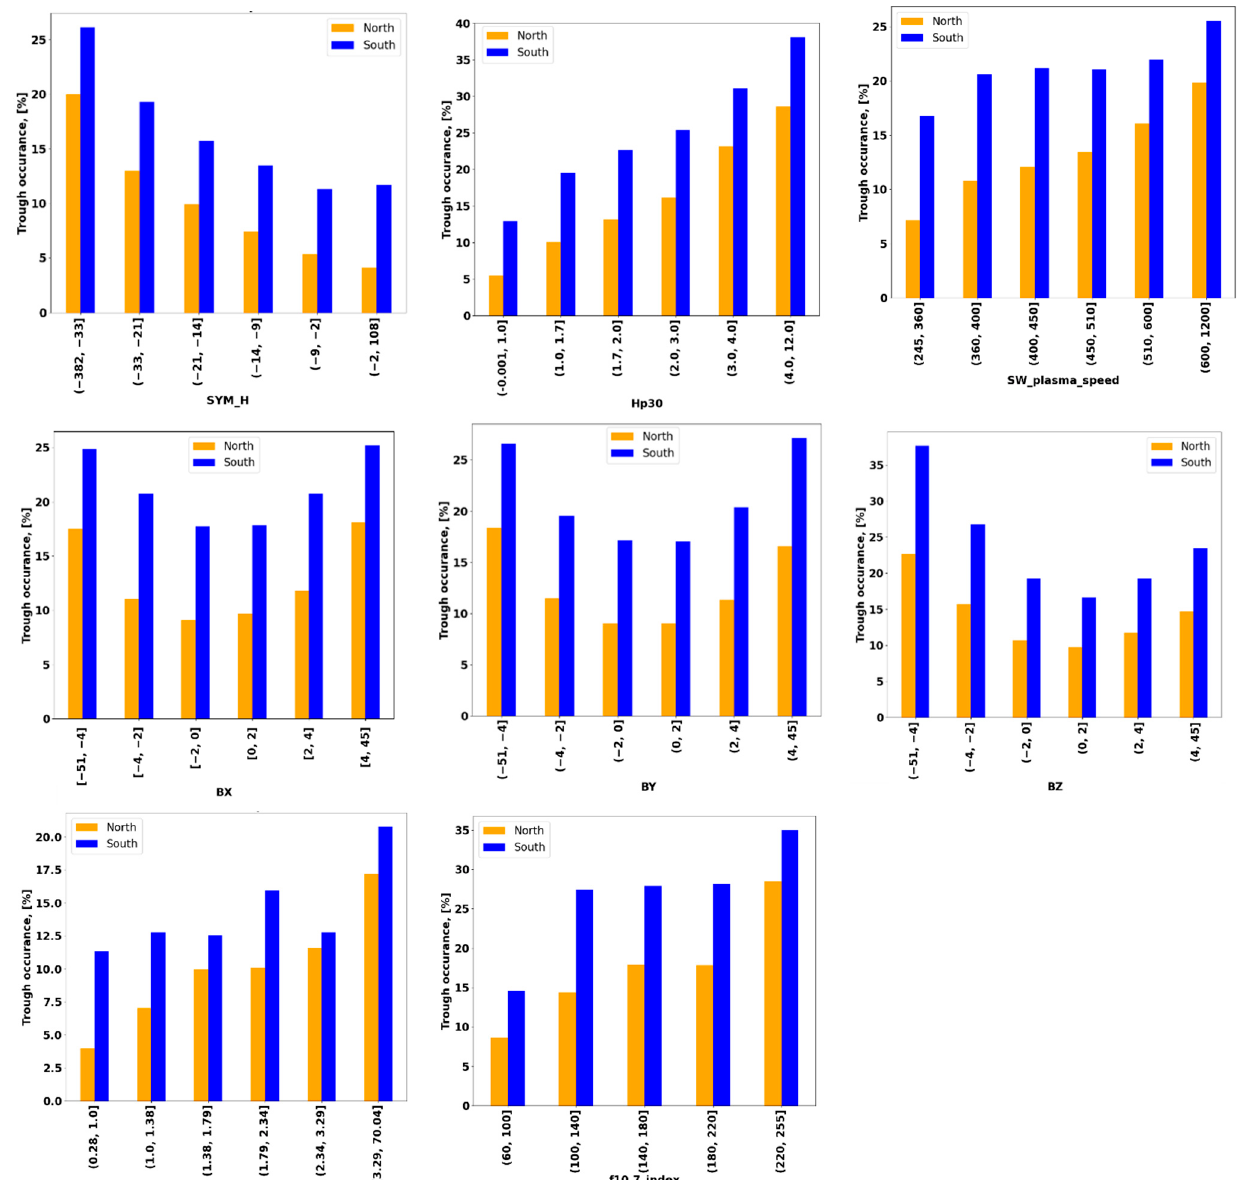
Figure 20. The occurrence of the trough depending on space weather indices for the northern and southern